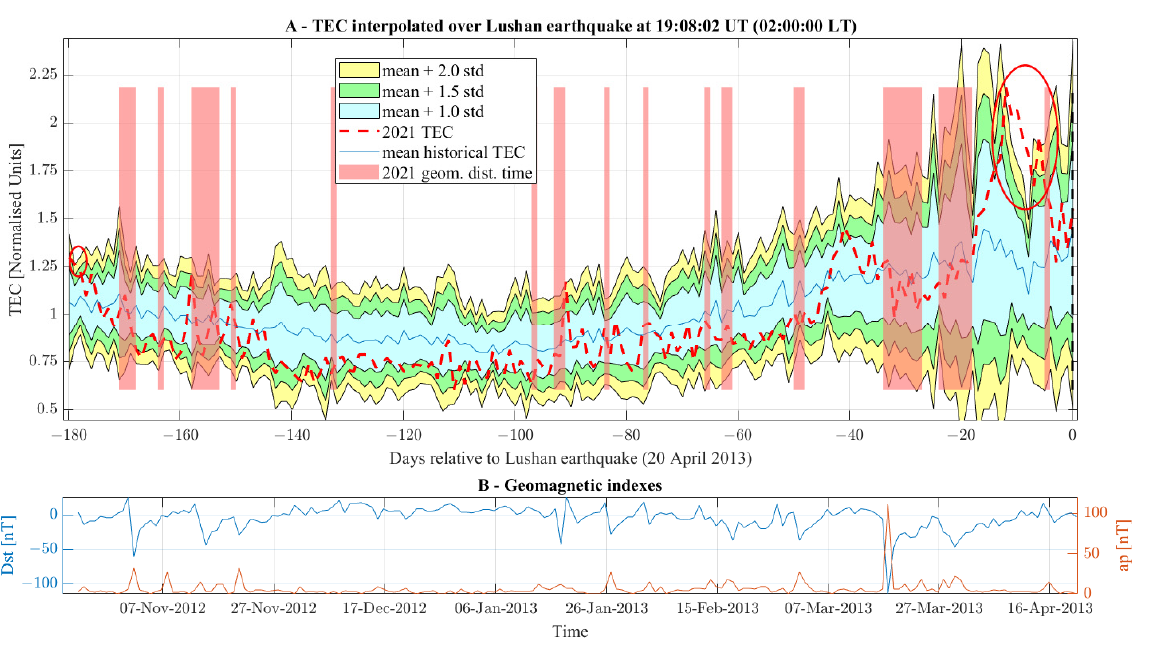
Figure 19. TEC time series from the six months before the Mw 6.7 Lushan 2013 earthquake. The original TEC data were retrieved by GIM-TEC and interpolated at 2 LT above the epicenter ( A ). The disturbed geomagnetic time (|Dst| > 20 nT and/or ap > 10 nT) is highlighted by light red boxes. The geomagnetic indices Dst and ap are shown in the lower panel ( B ).